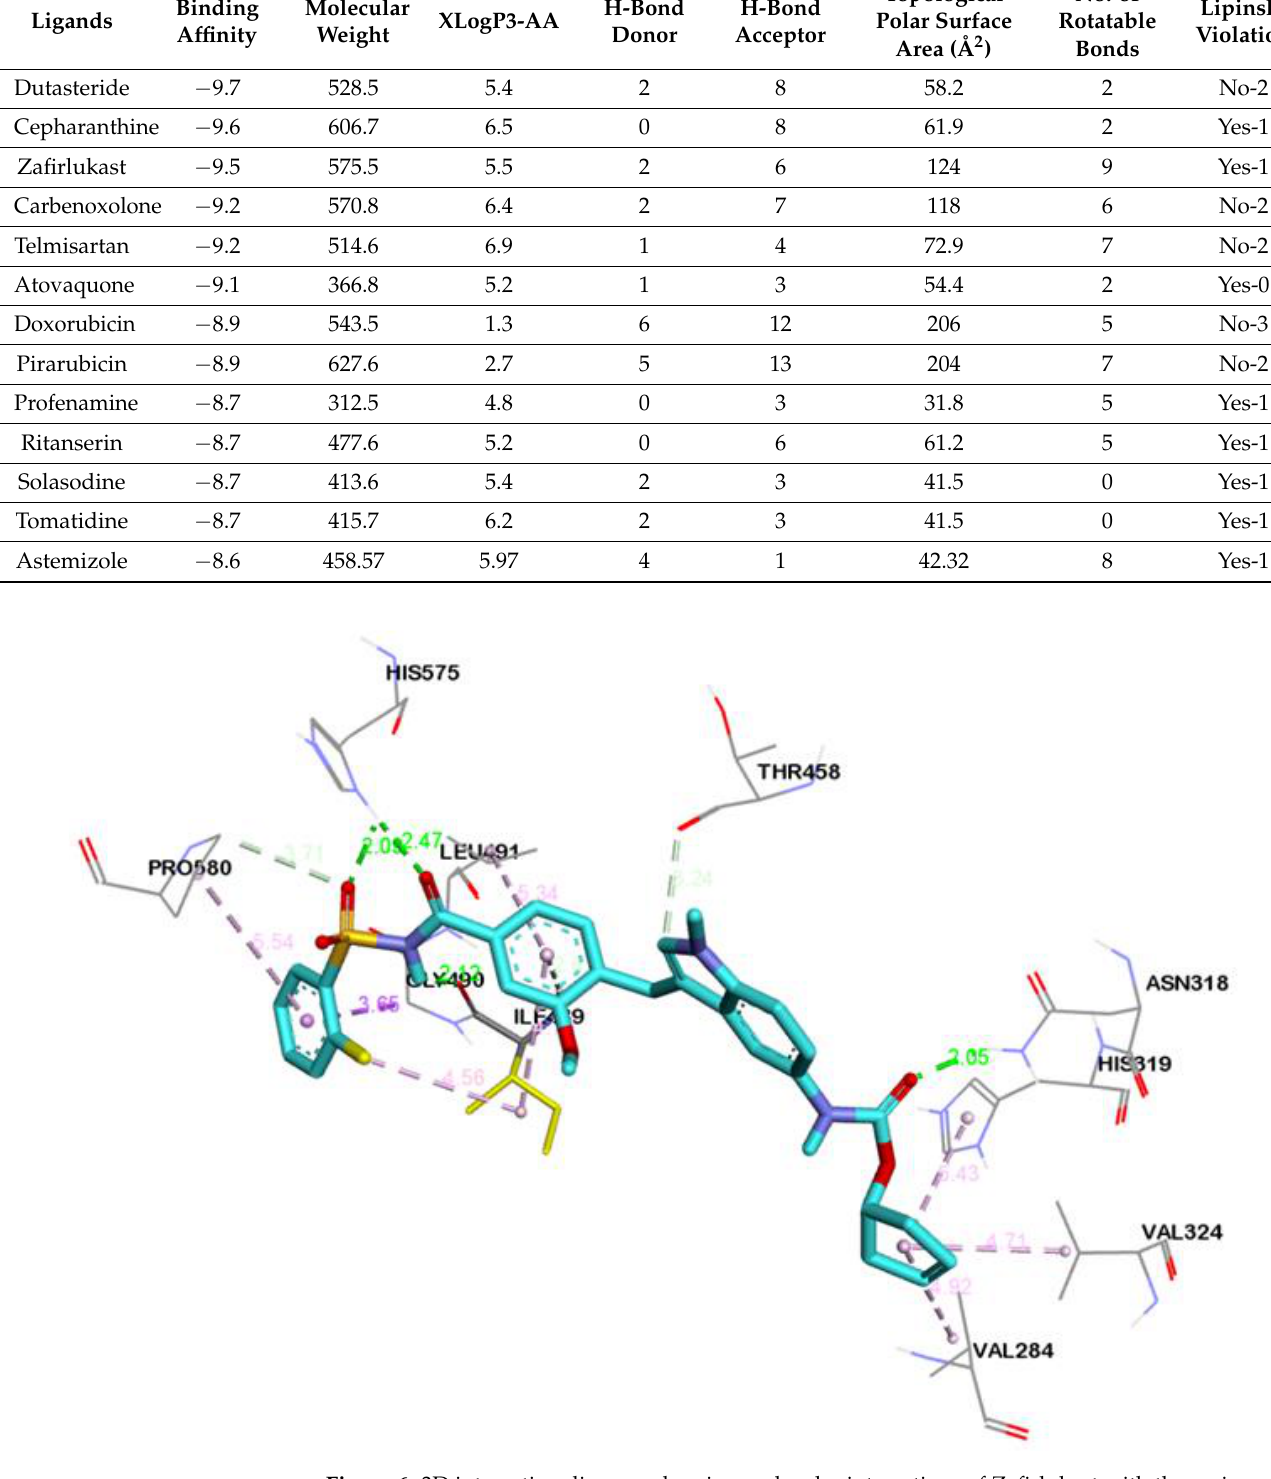
Figure 6. 3D interaction diagram showing molecular interactions of Zafirlukast with the amino acids (grey) mainly involved in the binding pocket identified. Molecular interactions include conventional hydrogen bond (green), carbon–hydrogen bond and pi–donor hydrogen bond (pale green), pi–sigma (purple), and alkyl and pi–alkyl (light pink).